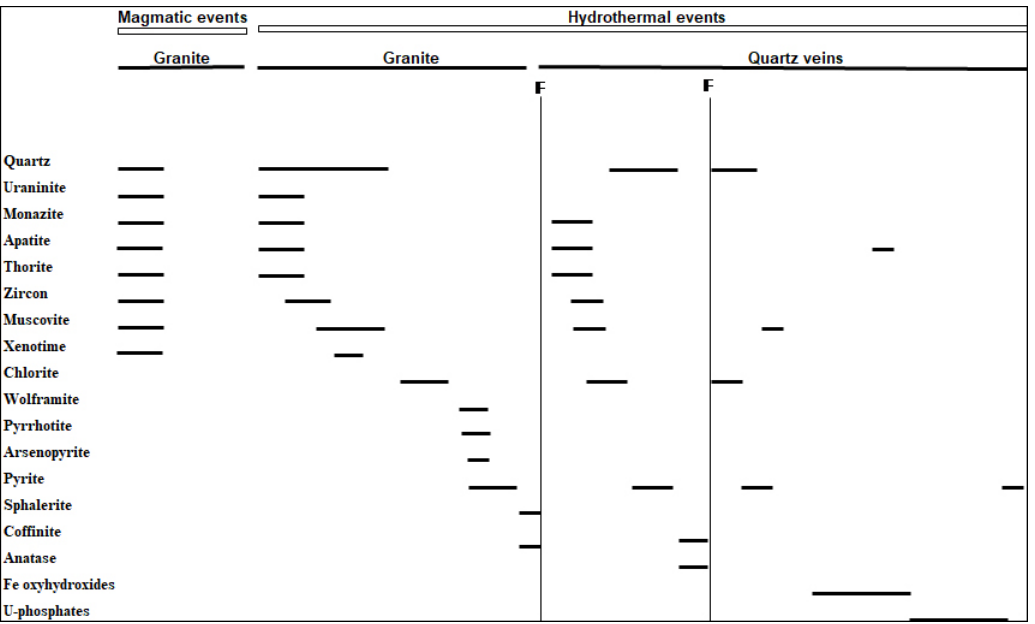
Figure 2. Paragenetic sequence of the accessory minerals and quartz of the granite, and of the mineralized quartz veins from Vale the Abrutiga. F: